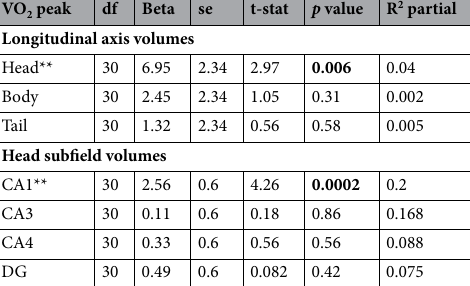
Table 2. Association between VO 2 peak and hippocampal volumes. Table of the associations between VO 2 peak and hippocampal subfields using linear mixed effect models. ** p < 0.007. Bold text reflects significant p -values after Bonferroni